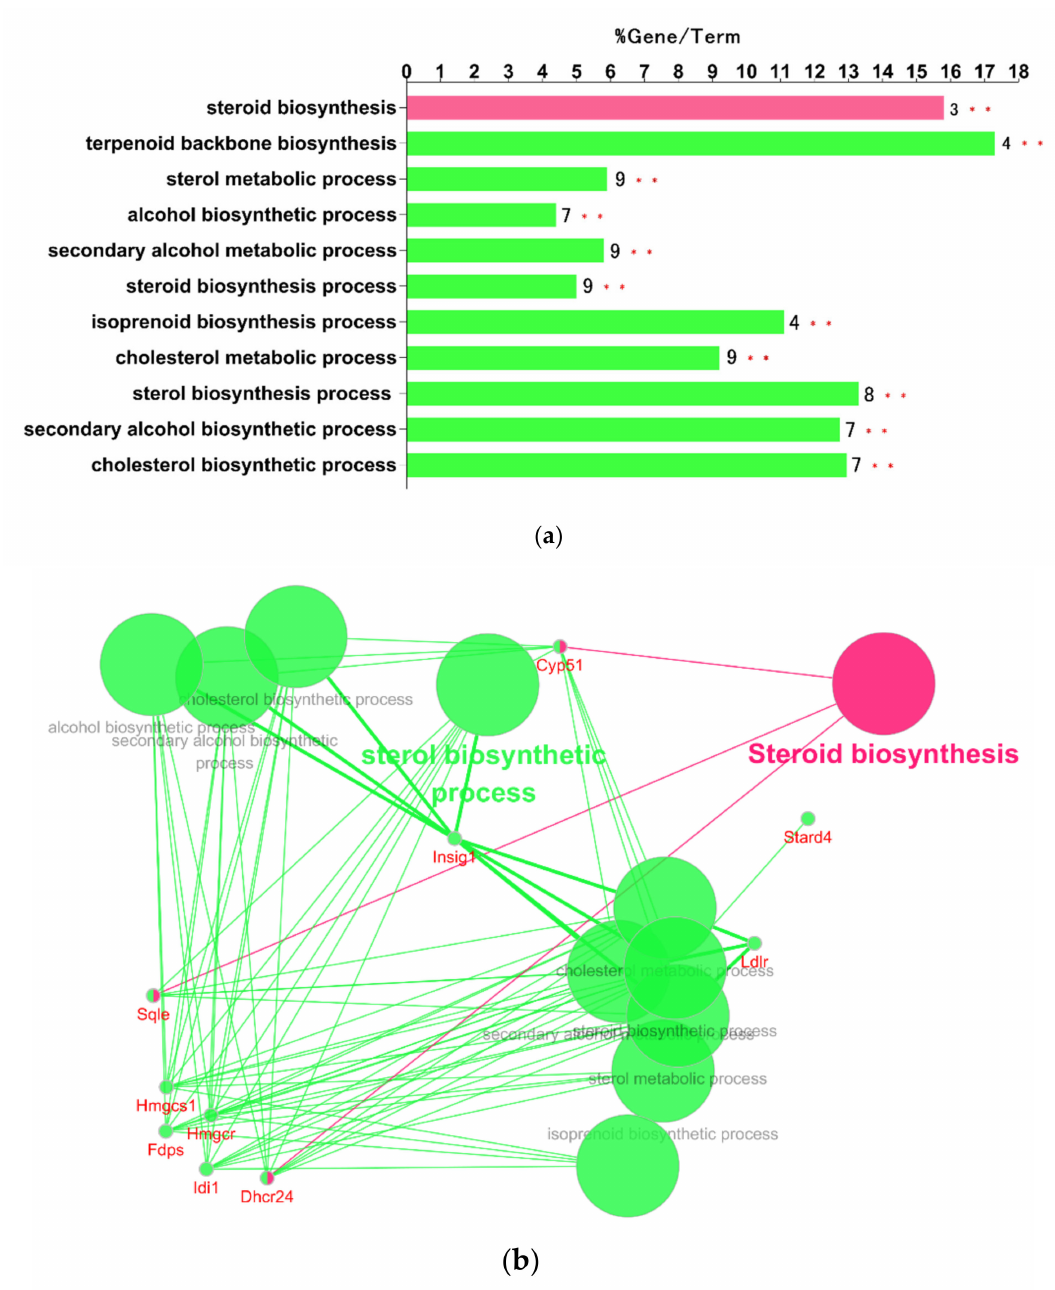
Figure 3. The 10 hub genes were mapped for functional enrichment analysis using the ClueGo tool. ( a ) The enriched pathways of 10 genes (di ff erent pathways were represented by di ff erent colors). ( b ) Pathway enrichment analysis with ClueGO for the 10 hub